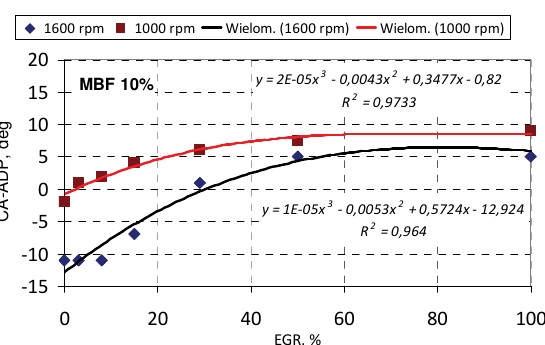
Fig. 11. Impact of EGR opening at MBF 5% value (190 Nm load)